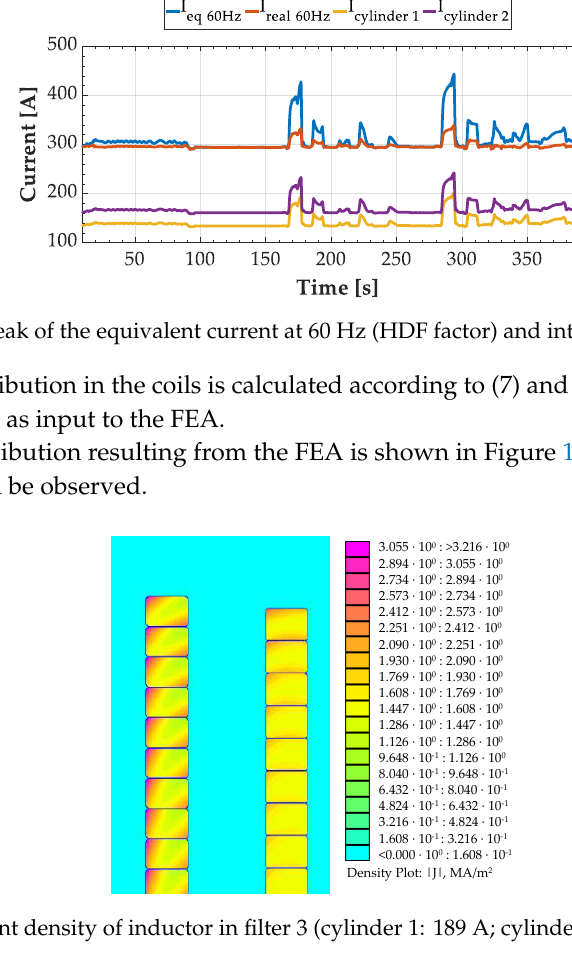
Table 8. Characterization of the results obtained through FEA.